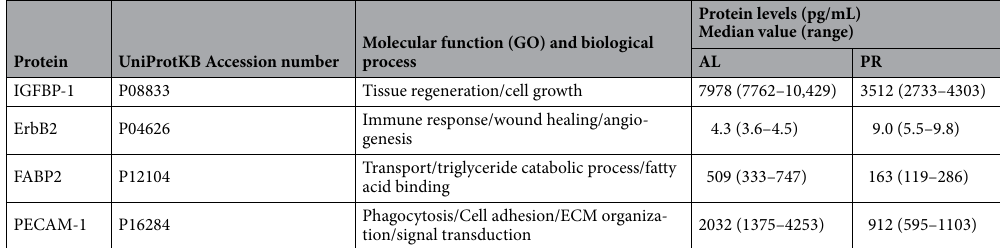
Table 3. Proteins differentially expressed in serum from patients undergoing aseptic hip revision (AL) and primary THA (PR), as quantified using specific-antibody arrays (in all proteins, p = 0.0357).